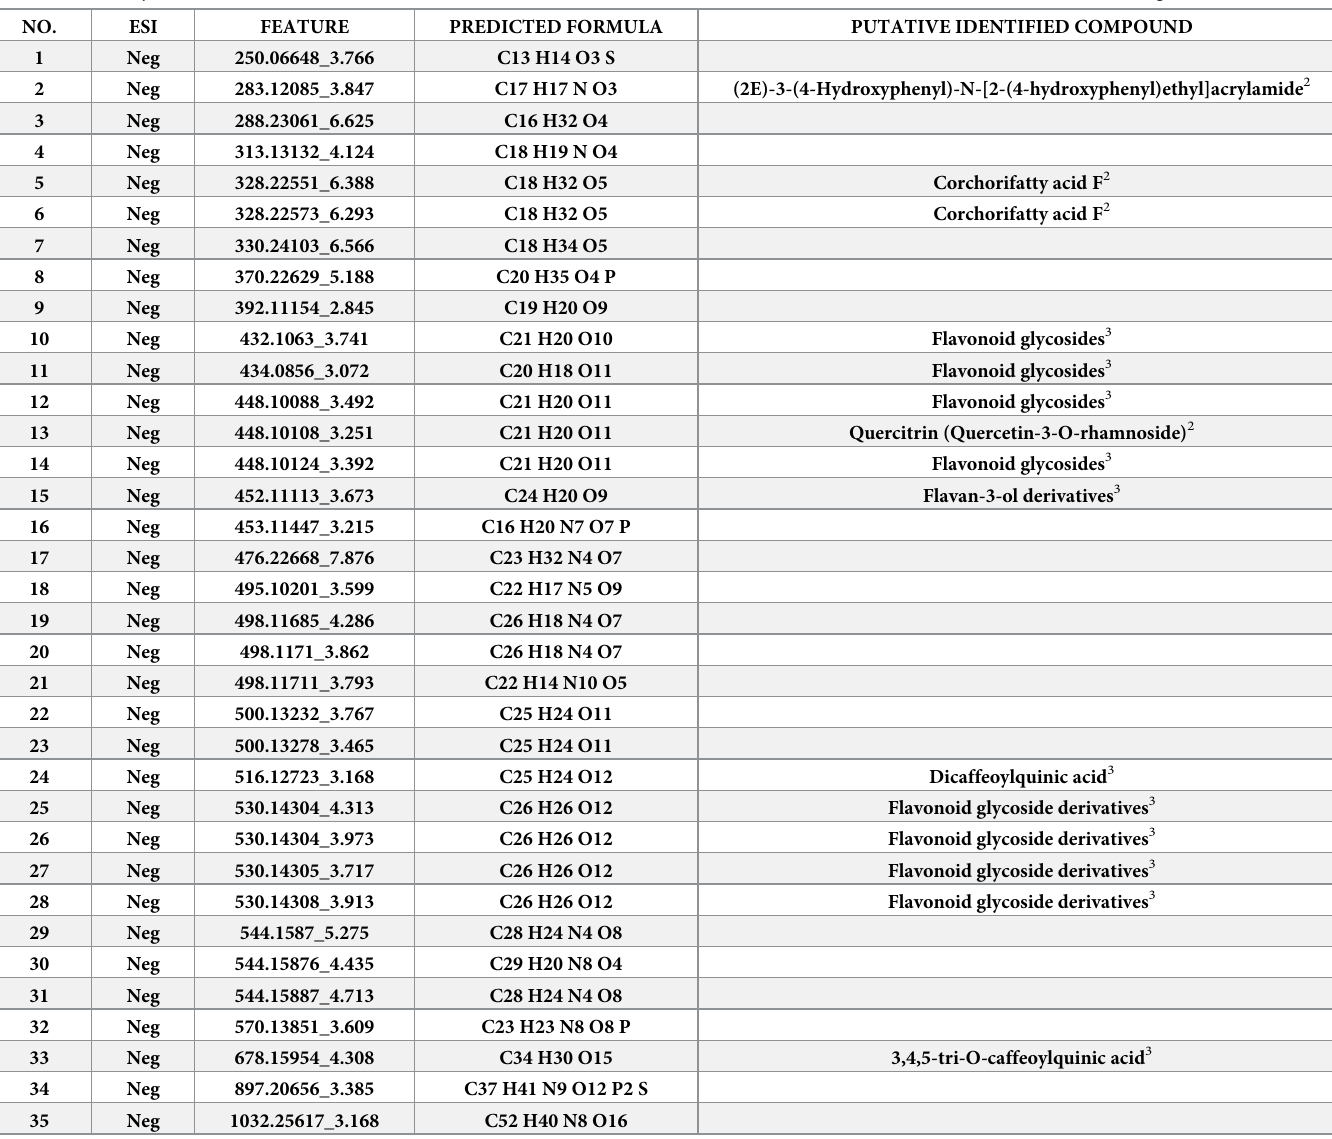
Table 4. Summary of metabolite features contributed to the discrimination between F3: EtOH/EtOAc and F5: EtOH/H 2 O fractions in ESI negative mode.